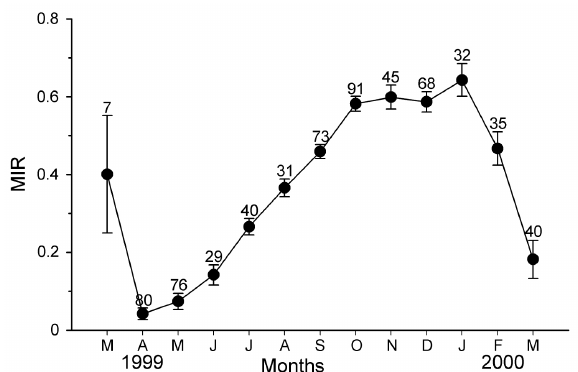
Fig . 4. – Monthly means of marginal increment ratio (Mir) of oto- liths of H. didactylus sampled between March 1999 and March 2000 in the Bay of Cádiz. Vertical bars are ± 1 se; numbers on the top of vertical bars are sample sizes.